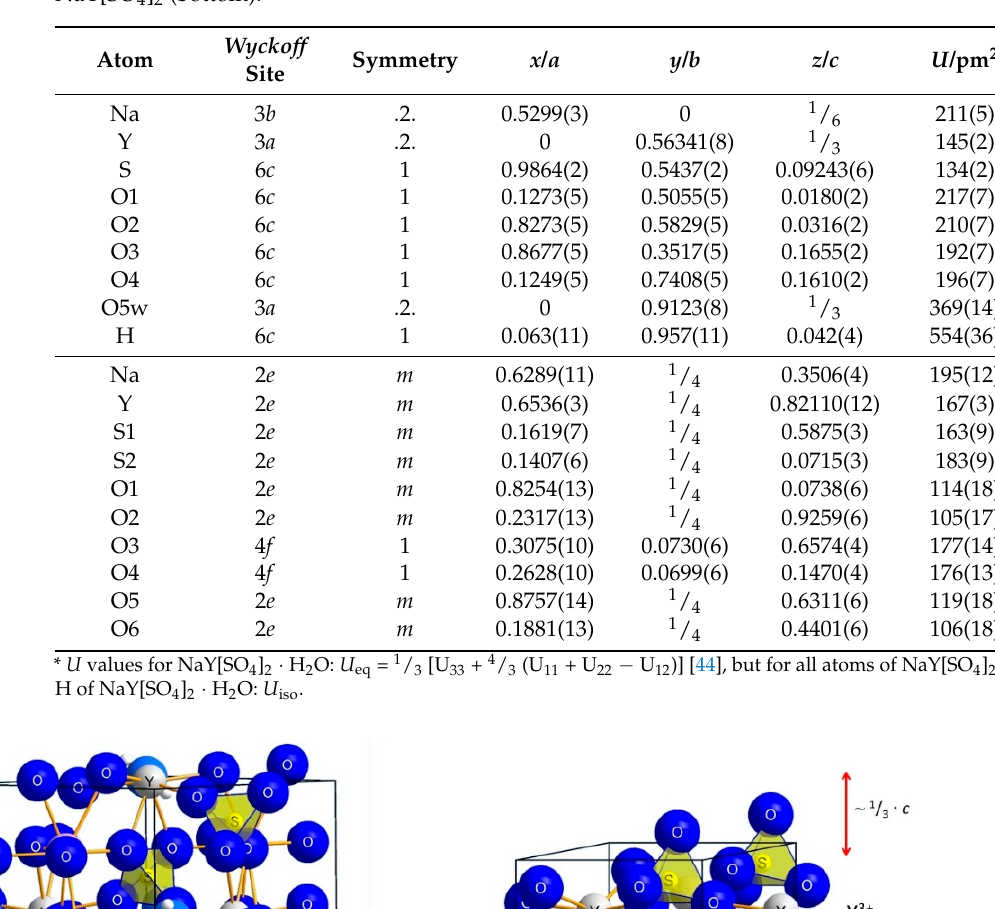
Table 2. Fractional atomic coordinates, site symmetry and U values * of NaY[SO 4 ] 2 · H 2 O (top) and NaY[SO 4 ] 2 (bottom).